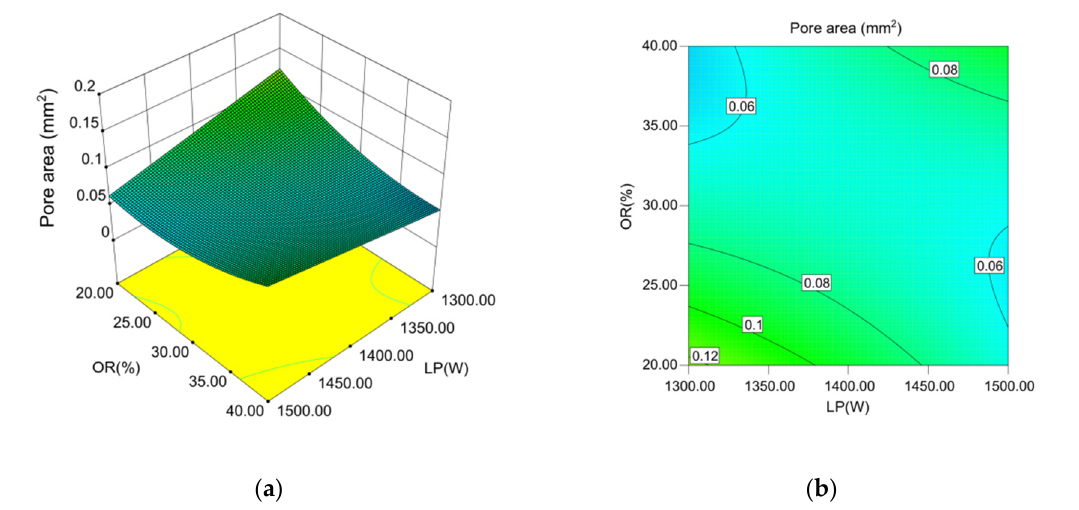
Figure 9. ( a ) Response surface of laser power and overlap ratio interaction affecting the pore area; ( b ) ( b ) Contour line of the response surface. Contour line of the response surface.